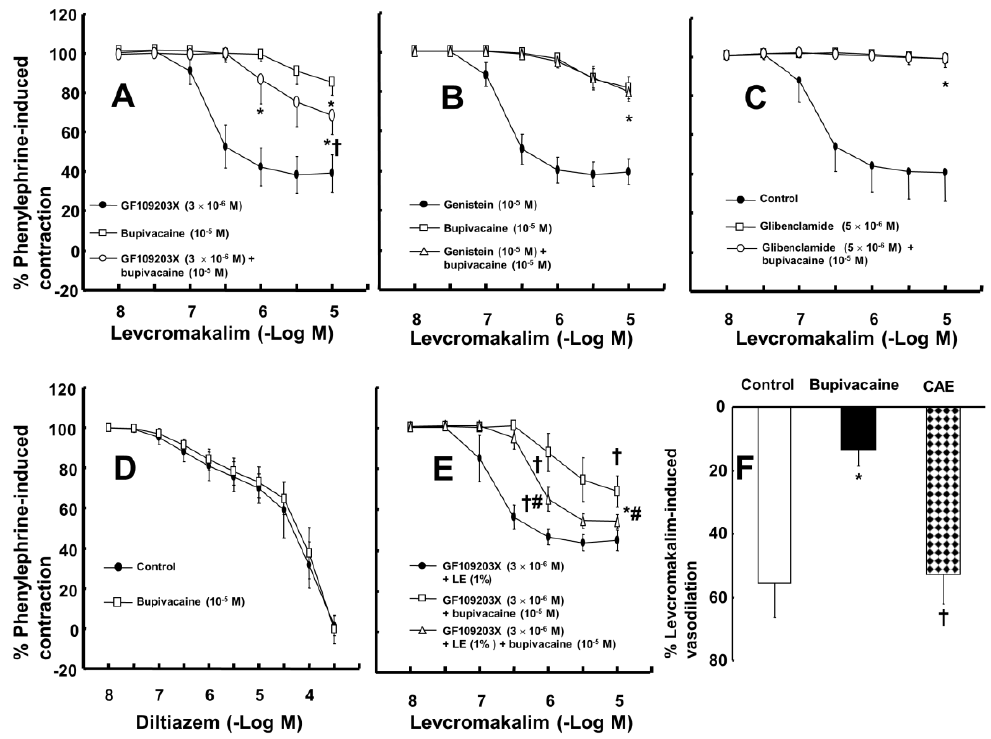
Figure 3. ( A , B ): Effect of GF109203X (( A ), n = 10) and genistein (( B ), n = 10) on the toxic dose of bupivacaine-mediated reduction of levcromakalim-evoked vasodilation in isolated rat aortas without endothelium. Data are expressed as the mean ± SD and shown as a percentage of the contraction evoked by phenylephrine. Data were analyzed by one-way analysis of variance (ANOVA) followed by Bonferroni’s multiple comparison test or Mann-Whitney test. n indicates the number of isolated rat aortas. Maximal vasodilation induced by levcromakalim (10 −5 M) or the logarithm (log ED 50 ) of the levcromakalim concentration needed to produce half of the maximal vasodilation induced by levcromakalim (10 −5 M): * p < 0.001 versus GF109023X or genistein alone, † p < 0.001 versus bupivacaine alone. ( C , D ): Effect of glibenclamide (( C ), n = 10) on the toxic dose of bupivacaine-mediated reduction of levcromakalim-evoked vasodilation in isolated rat aortas without endothelium and the effect of bupivacaine (( D ), n = 10) on the diltiazem-evoked vasodilation in isolated rat aortas without endothelium. Data are expressed as the mean ± SD and shown as a percentage of the contraction evoked by phenylephrine. Data were analyzed by one-way ANOVA followed by Bonferroni’s multiple comparison test or unpaired Student’s t -test. n indicates the number of isolated rat aortas. Maximal vasodilation induced by levcromakalim (10 −5 M): * p < 0.001 versus control. ( E ): Effect of GF109203X and the combined treatment of GF109203X and lipid emulsion (LE) on the toxic dose of bupivacaine-mediated reduction of levcromakalim-evoked vasodilation in isolated rat aortas without endothelium. Data ( n = 10) are expressed as the mean ± SD and shown as a percentage of the contraction evoked by phenylephrine. Data were analyzed by one-way ANOVA followed by Bonferroni’s multiple comparison test. n indicates the number of isolated rat aortas. Maximal vasodilation induced by levcromakalim (10 −5 M) or log ED 50 : * p < 0.01 and † p < 0.001 versus GF109203X plus LE, # p < 0.001 versus GF109203X plus bupivacaine. ( F ): Effect of bupivacaine (10 −5 M) alone and centrifuged aqueous extract (CAE), which corresponds to the bupivacaine (10 −5 M)-containing LE (1%) obtained from a mixture of LE and bupivacaine by ultracentrifugation, on the levcromakalim (10 −5 M)-induced vasodilation from the phenylephrine-induced contraction of rat aortas without endothelium. Data ( n = 8) are expressed as the mean ± SD and shown as a vasodilation percentage from the maximal contraction evoked by phenylephrine. Data were analyzed by one-way ANOVA followed by Bonferroni’s multiple comparison test. n indicates the number of isolated rat aortas. * p < 0.001 versus control. † p < 0.001 versus bupivacaine alone.